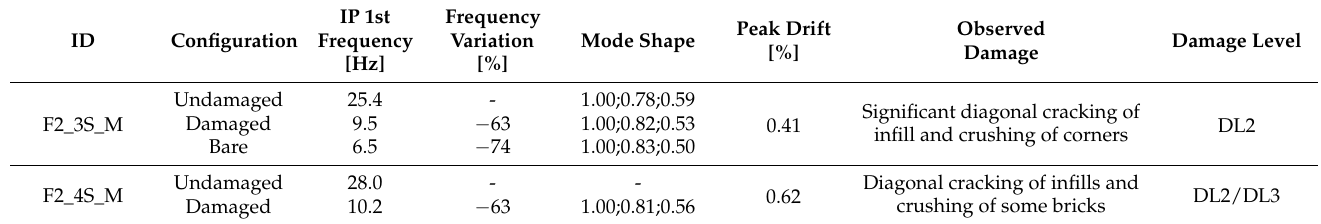
Table 5. Summary of modal identification results via OMA for the first in-plane mode.